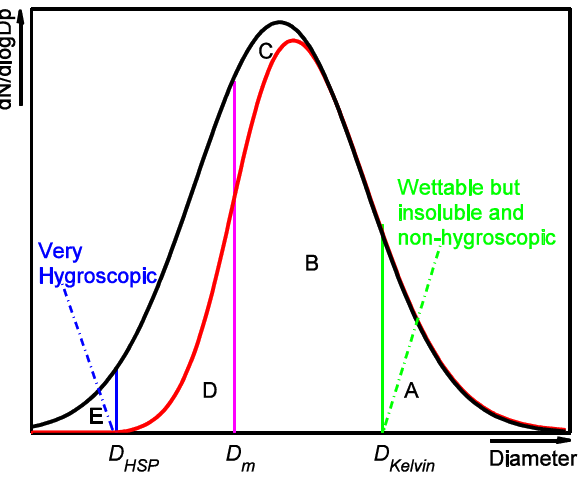
Figure 2 Schematic of the Relationship between Aerosol and CCN The black curve represents the aerosol size distribution, while only the particles under the red curve act as CCN. D m is regarded as an inferred critical dry diameter at the given SS. The number concentration of the aerosols larger than D m equals to the N CCN . D NaCl is the critical dry diameter of NaCl particle at the given SS. D Kelvin is the critical diameter for an insoluble but wettable particle (IBW) at the given SS. All the aerosol particles with diameter larger than D Kelvin (area A) can be activated, while the atmospheric aerosol particles smaller than D NaCl (area E) cannot be activated. The area C and D equals to each other.